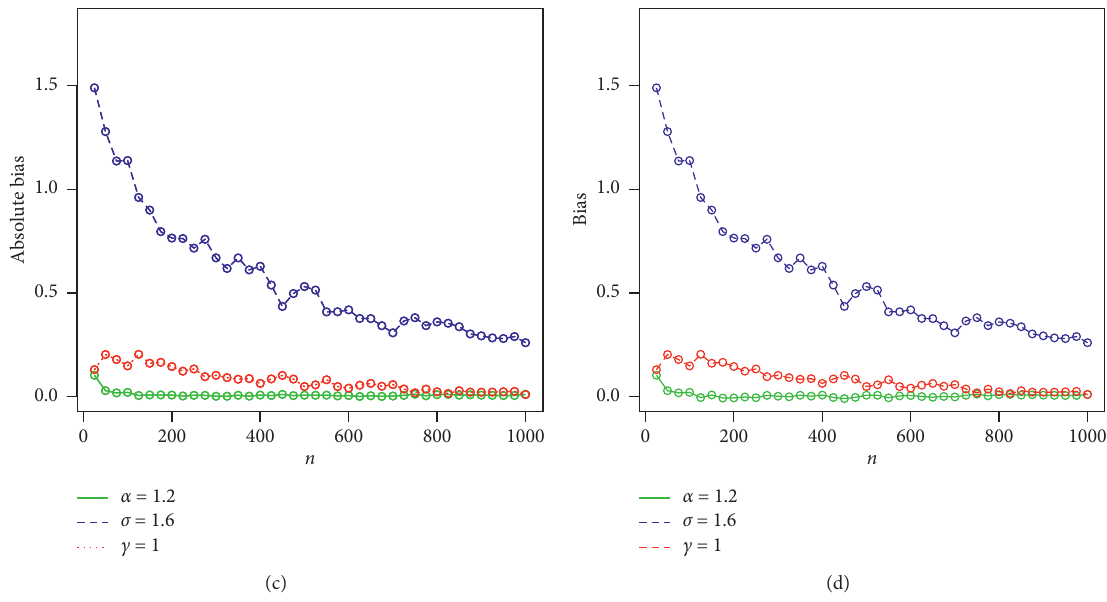
Figure 4: Plots of the estimated parameters, MSEs, absolute biases, and biases for α � 1 . 2, σ � 1 . 6 � , and c � 1. (a) Plot of estimated parameters versus n . (b) Plot of MSE versus n . (c) Plot of absolute bias versus n . (d) Plot of bias versus n